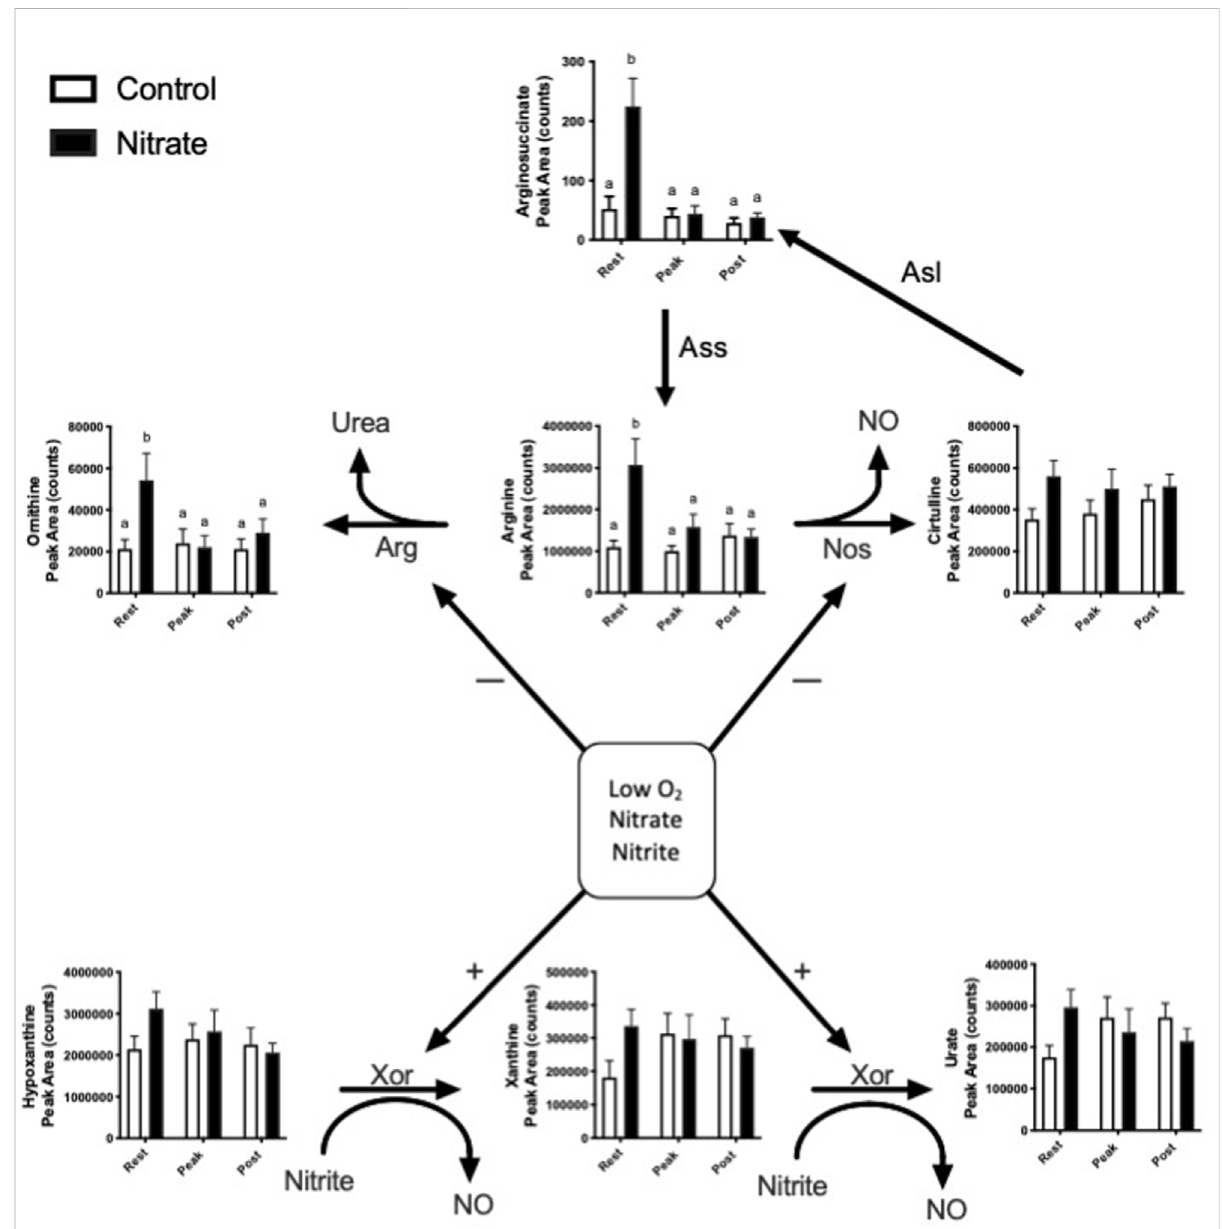
FIGURE 2 Metabolites related to NO homeostasis in zebra fi sh. Relative levels of metabolites metabolized by nitric oxide synthase (NOS), arginase (ARG) and xanthine oxidoreductase (XOR). Citrulline can also be recycled back to arginine. Asl, argininosuccinate lyase; Ass, argininosuccinate synthase. Labeled means without a common letter differ. (One-way ANOVA with Fisher ’ s post-hoc and Holm FDR-correction, p < 0.1 indicating signi fi cance, n = 7 –